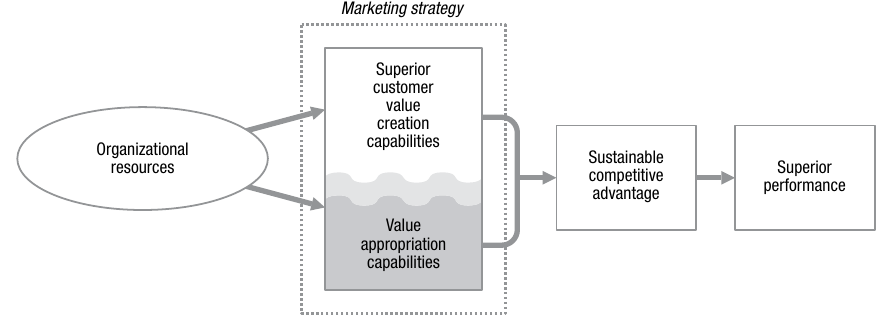
Fig. 1. Marketing strategy and sustainable competitive advantage Source : Mizik and Jacobson (2003).